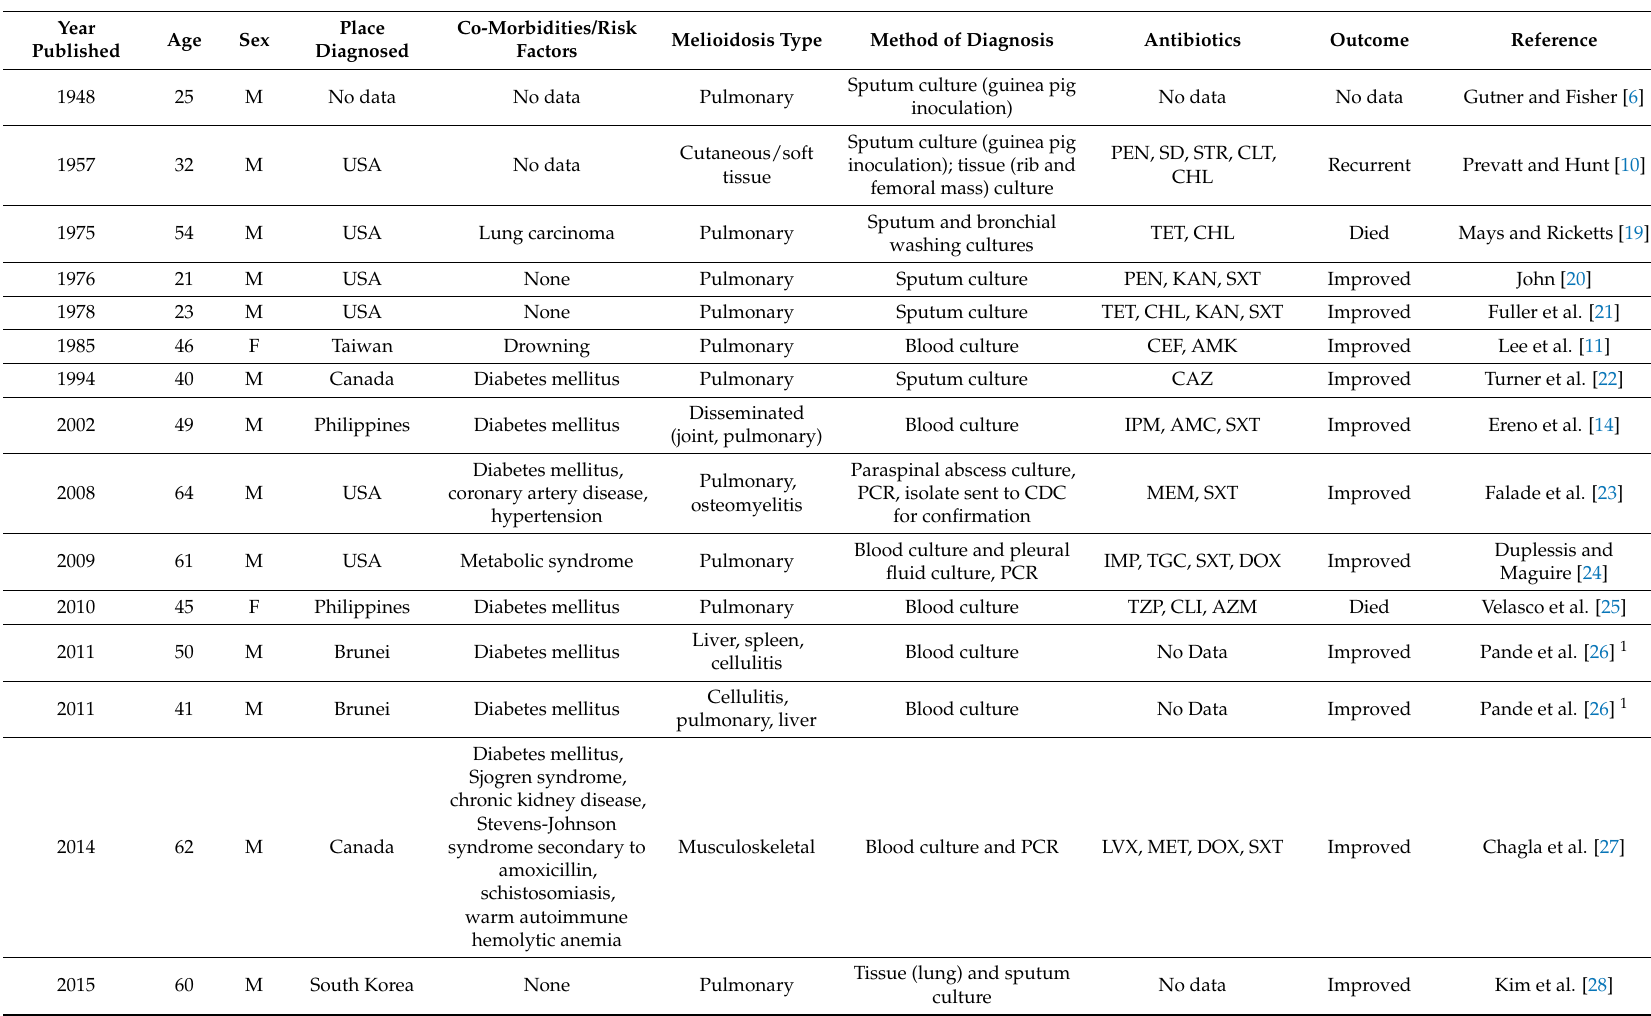
Table 1. Clinical characteristics of culture confirmed cases of melioidosis in the Philippines from published case